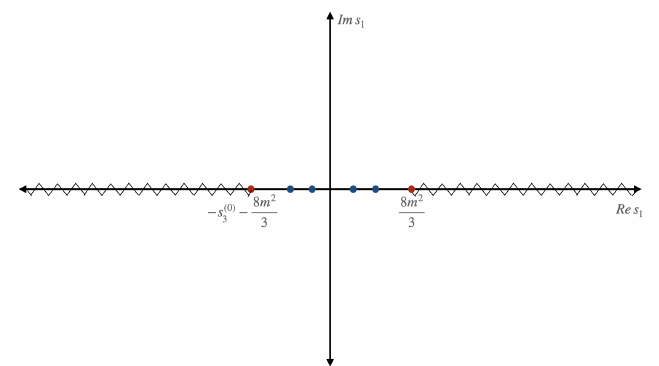
Figure 12. The location of the poles and branch cuts in the complex s 1 plane.